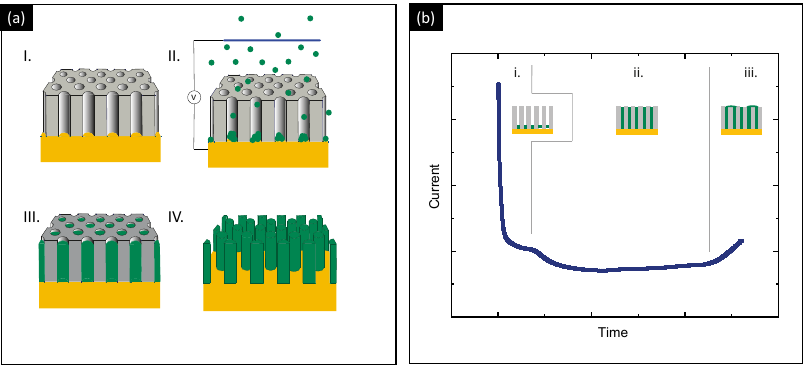
Figure 1. ( a ) Schematics of the protocol for the growth of nanowires inside a nanoporous template: metallization of the template (I ), nucleation (II), growth (III) and removal of the template to release the nanowires (IV). ( b ) Evolution of the cathodic current during an electrodeposition process of nanowires inside the